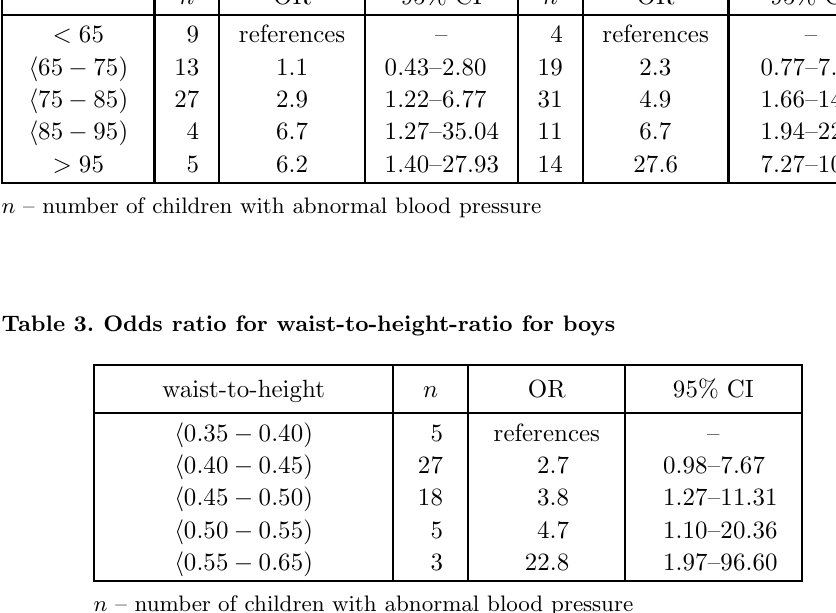
Table 2. Odds ratio for heart rate for girls and boys Boys